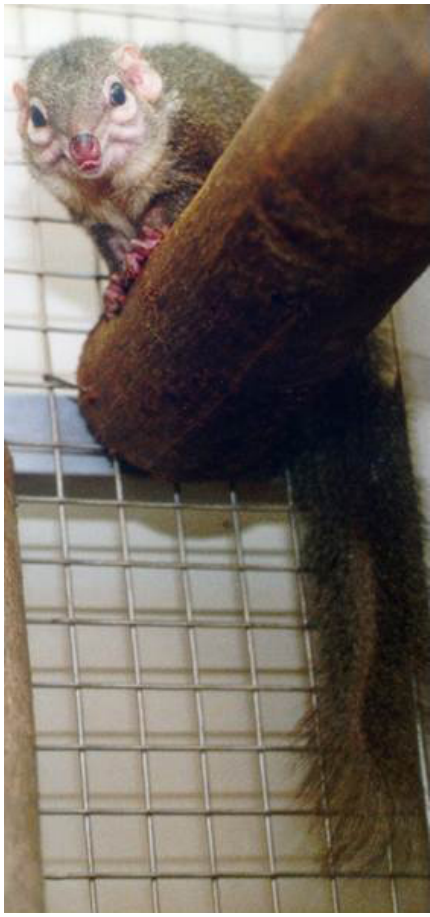
Figure 2. Adult male tree shrew ( Tupaia belangeri ) from the DPZ colony.